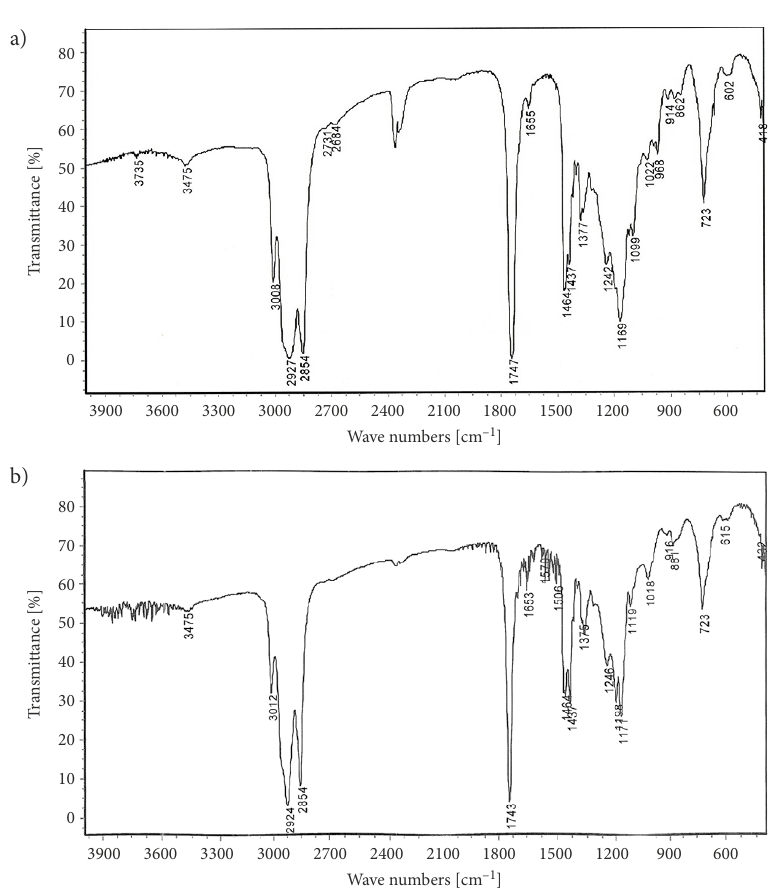
Figure 9. The FTIR spectra of BAO (a) and its optimal BD (b)